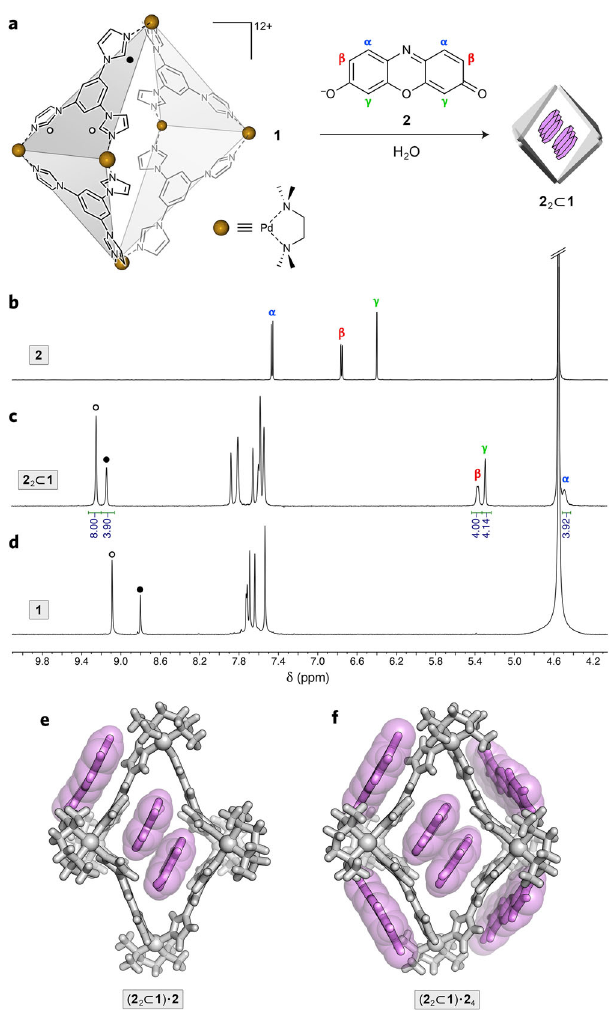
Fig. 1 Encapsulation of resoru fi n within coordination cage 1. a Structural formulas of coordination cage 1 (counterions = 12 NO 3 − ), resoru fi n 2 , and a cartoon representation of the inclusion complex 2 2 ⊂ 1 . The two types of acidic imidazole protons in 1 are denoted by black and white circles. b 1 H NMR spectrum of 2 (600 MHz, D 2 O, 320 K). c Partial 1 H NMR spectrum of 2 2 ⊂ 1 (600 MHz, D 2 O, 320 K) (for full-range 1 H and 13 C spectra, see Supplementary Figs. 1 and 2). d Partial 1 H NMR spectrum of 1 (600 MHz, D 2 O, 320 K). e Crystal structure of 2 2 ⊂ 1 co-crystallized with 1 equiv of unencapsulated 2 ; i.e., ( 2 2 ⊂ 1 ) ⋅ 2 . f Crystal structure of 2 2 ⊂ 1 co-crystallized with 4 equiv of unencapsulated 2 ; i.e., ( 2 2 ⊂ 1 ) ⋅ 2 4 . Nitrate counterions and water molecules were omitted for